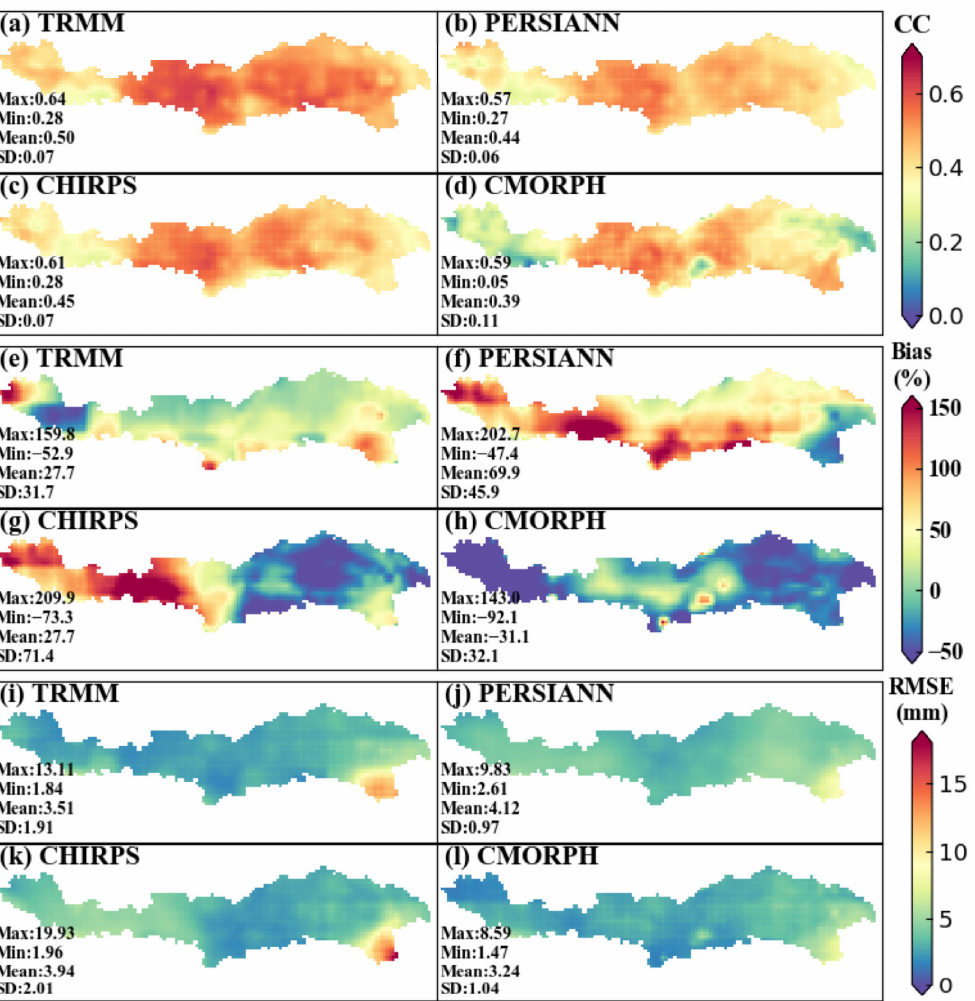
Figure 4. Spatial distribution of correlation metrics (CC, Bias, RMSE) of daily precipitation during 2000–2008: ( a – d ) the spatial distribution of CC values; ( e – h ) the spatial distribution of bias values; ( i – l ) the spatial distribution of RMSE